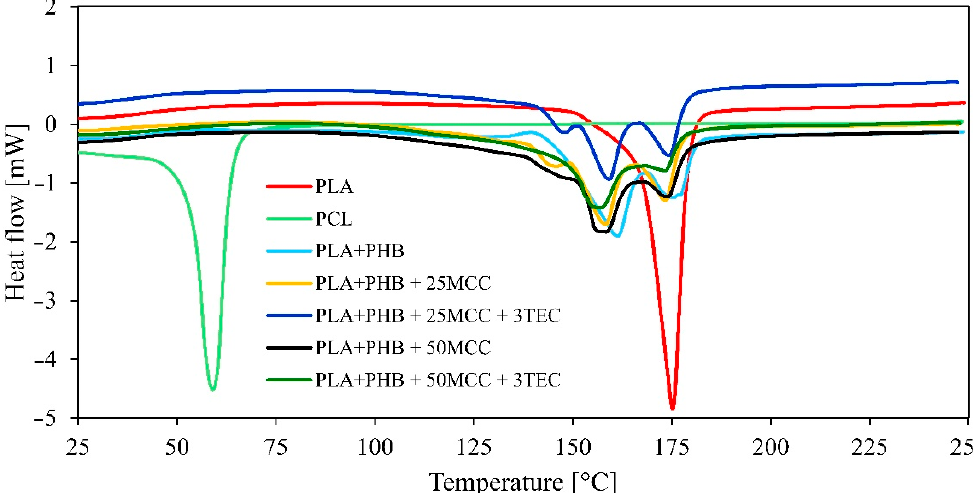
Figure 3. Differential scanning calorimetry (DSC). Table 3. Thermal stability estimators for the investigated biopolymers and biopolymer blend samples. Tested